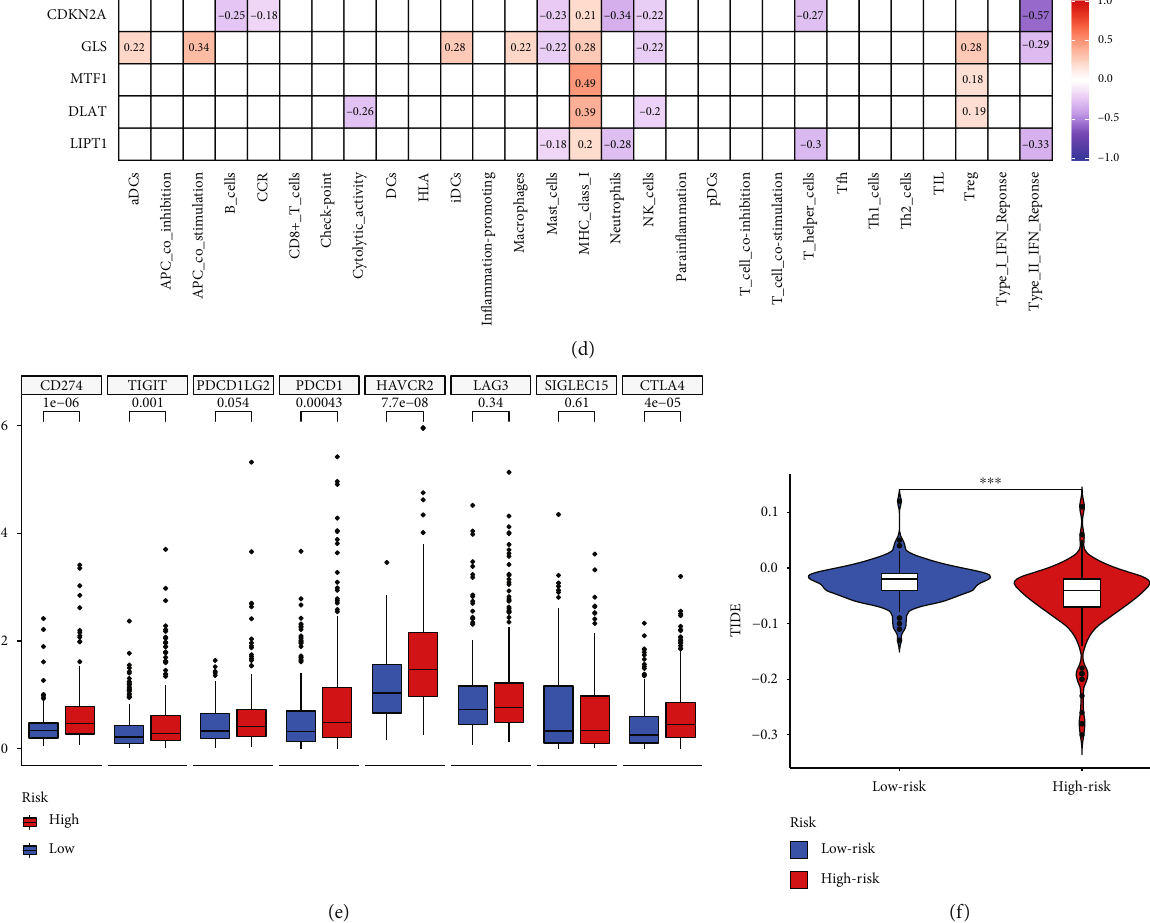
Figure 12: The immune landscape of cuproptosis-related risk score in HCC. (a) The forest plot displayed the connection between risk score and immune cell in fi ltration through TIMER, CIBERSORT, CIBERSORT-ABS, QUANTISEQ, MCPcounter, XCELL, and EPIC algorithms. (b, c) The bar graphs showed the di ff erence in immune cell subpopulations and related functions between high-risk and low-risk groups. (d) The heatmap displayed the relationship of immune cell subpopulations and related functions with the fi ve prognostic genes. (e) Di ff erences in immune checkpoint expression between high-risk and low-risk groups. (f) The violin plots presented the TIDE scores between high-risk and low-risk groups. ∗ p < 0 : 05 , ∗∗ p < 0 : 01 , ∗∗∗ p < 0 : 001